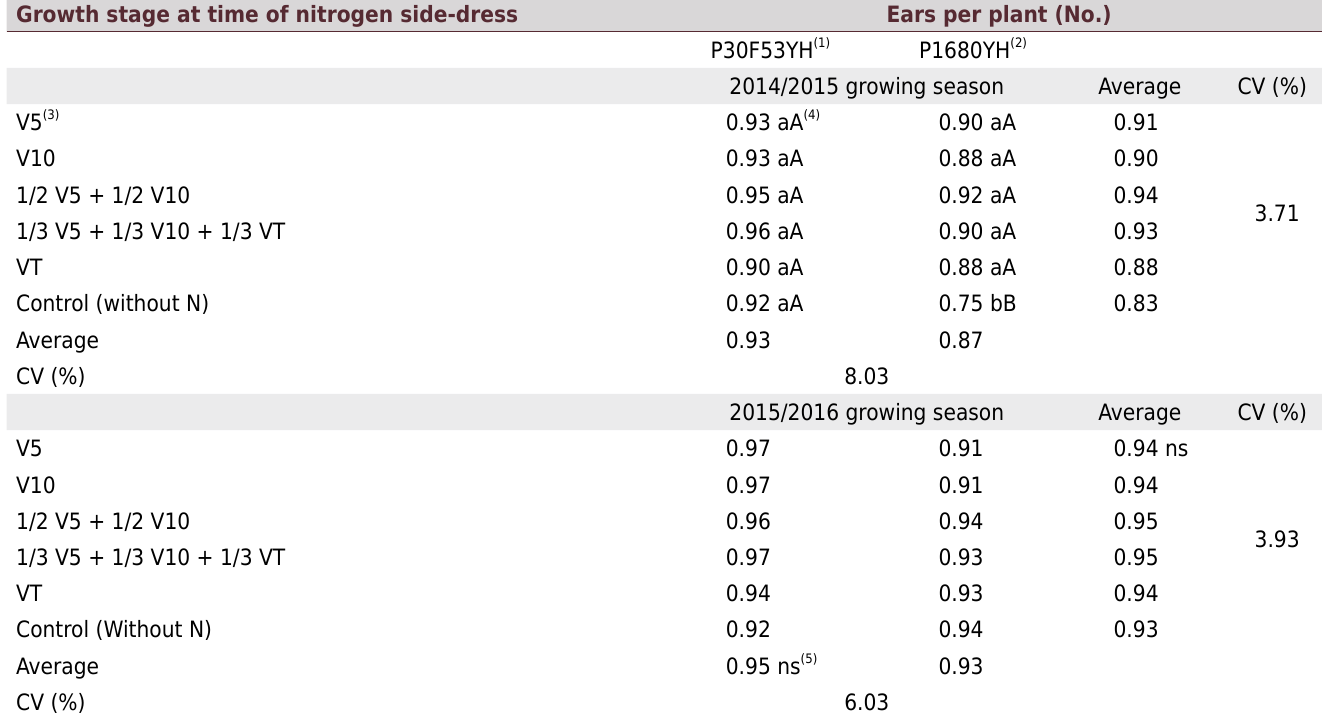
Table 3. Number of ears per plant of two corn hybrids as affected by the growth stage of plants at the time of nitrogen side-dress fertilization in Lages, Santa Catarina, Brazil Growth stage at time of nitrogen side-dress Ears per plant